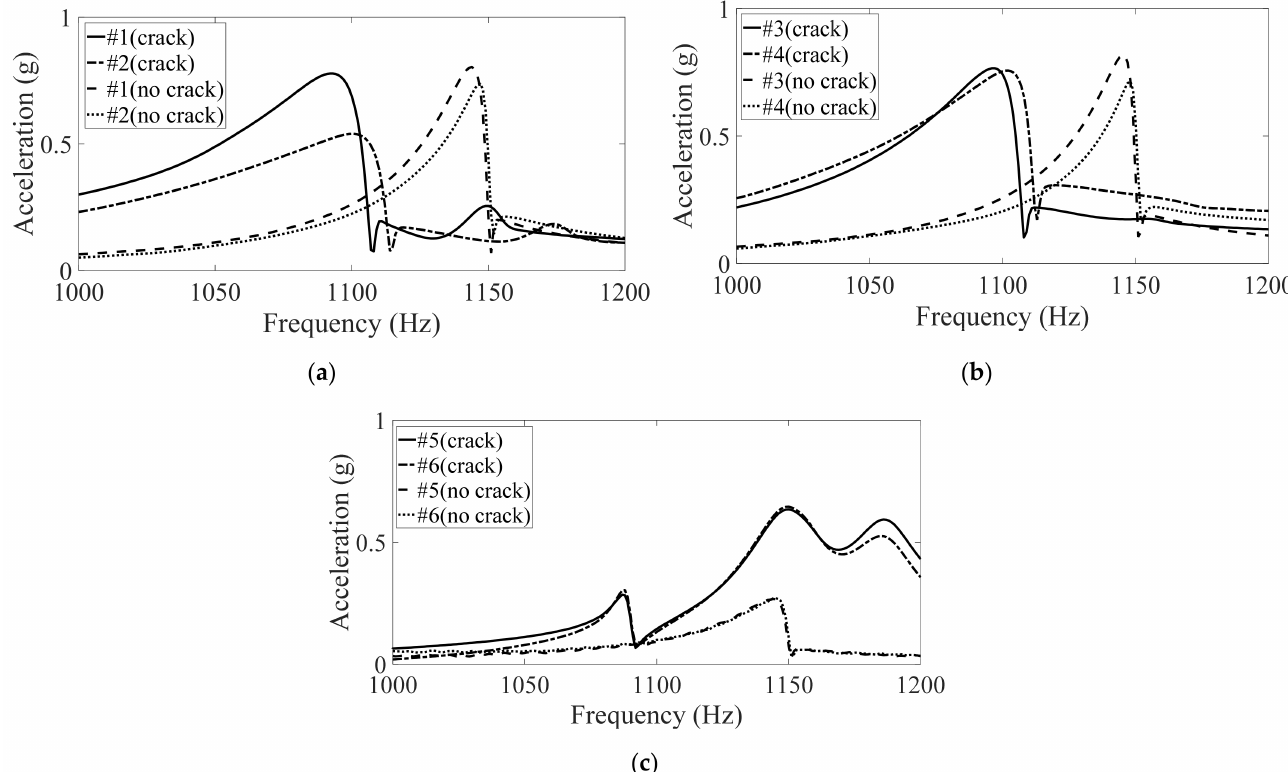
Figure 8. Acceleration response of two specimens: ( a ) X-Y plane (front), ( b ) X-Y plane (rear), and ( c ) X-Z